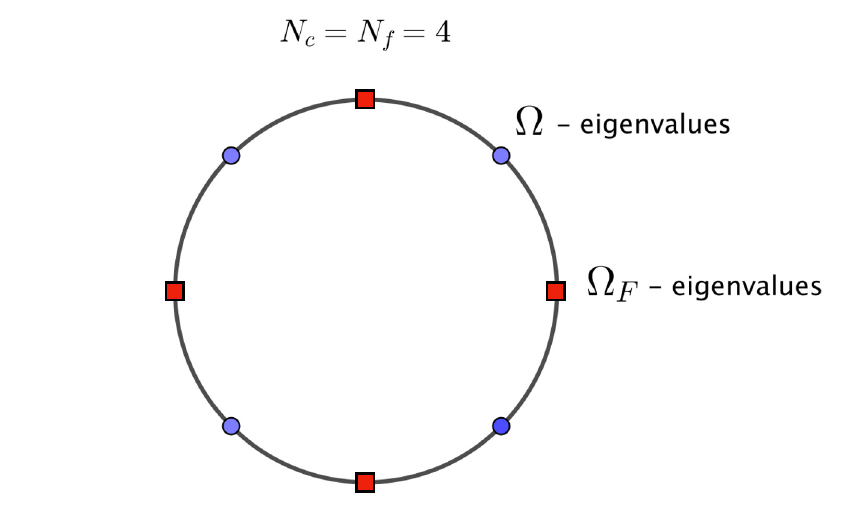
Figure 7 . The flavor-holonomy is non-dynamical, and gauge holonomy is dynamical. But the value of flavor-holonomy determines the gauge holonomy potential and its minimum. In quantum distillation discussion over the Hilbert space, we establish Ω 0 energy for flavor holonomy. Despite Ω potentials are physically meaningful. For Ω